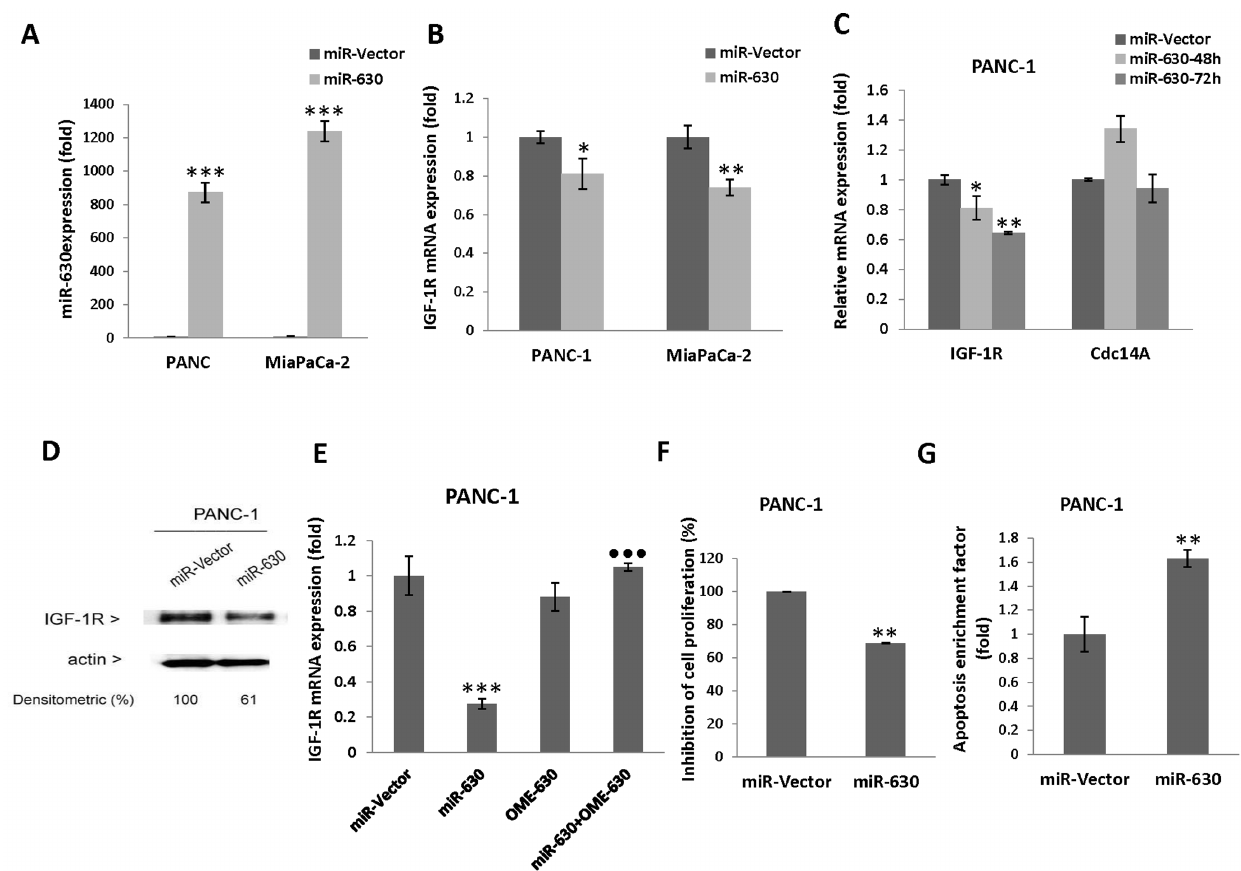
Figure 7. Over-expression of pre-miR-630 reduced IGF-1R expression and inhibited cell growth and induced apoptosis in cells. (A) pre-miR-630 expression in PANC-1 and MiaPaCa-2 cells. (B and C) Increased expression of pre-miR-630 decreased IGF-1R mRNA but not Cdc14A in cells. (D). Decreased IGF-1R protein expression in pre-miR-630 expressed cells. (E) Inhibitor 2 9 -O-methylated miR-630 (OME-630) blocked the IGF-1R mRNA degradation. Cells were transiently transfected with pre-miR-630 for 48 h (F and G) pre-miR-630 expression inhibited growth and induced apoptosis in PANC-1 cells. Inhibition of cell proliferations was evaluated after 48 h of pre-miR-630 transiently transfected cells by MTT assay and expressed as percent of that inhibited at a time relative to the miR-vector control. The error bars represent the mean of four separate determinations N 6 the standard deviation (SD). *, ** and *** ( , 0.05, , 0.01 and , 0.001) were significantly different in comparison between miR-vector and miR-630; was highly significant and represented the comparison between miR-630 to miR-630 + OME-630 using t -Test. Apoptosis of miR-630 cells was evaluated after 48 h of transfected cells. The cell death was measured by cytoplasmic histone-associated-DNA-fragments by ELISA (enrichment factor=OD of miR-630 expressed lysate/OD of miR-vector, OD at 405 nm-490